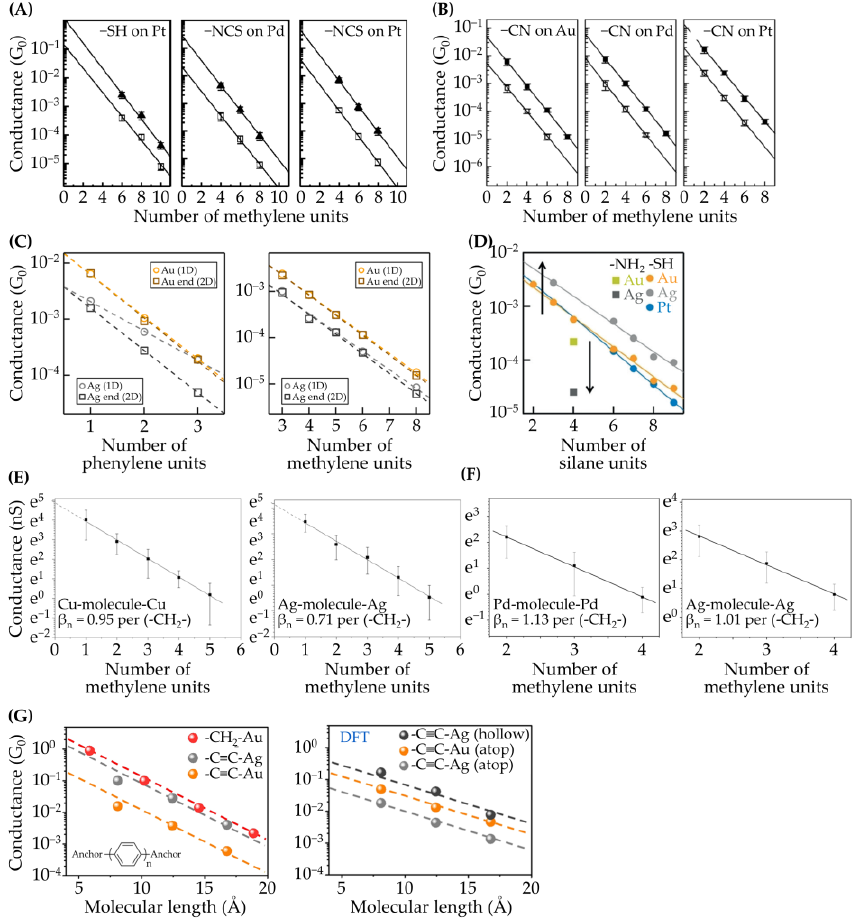
Figure 4. Effects of electrode materials on junction conductance. The transport efficiency across the molecule–electrode contacts is evaluated according to the values of contact conductance (G n =0 ), which are determined by the intercept in the plot of conductance versus molecular length.